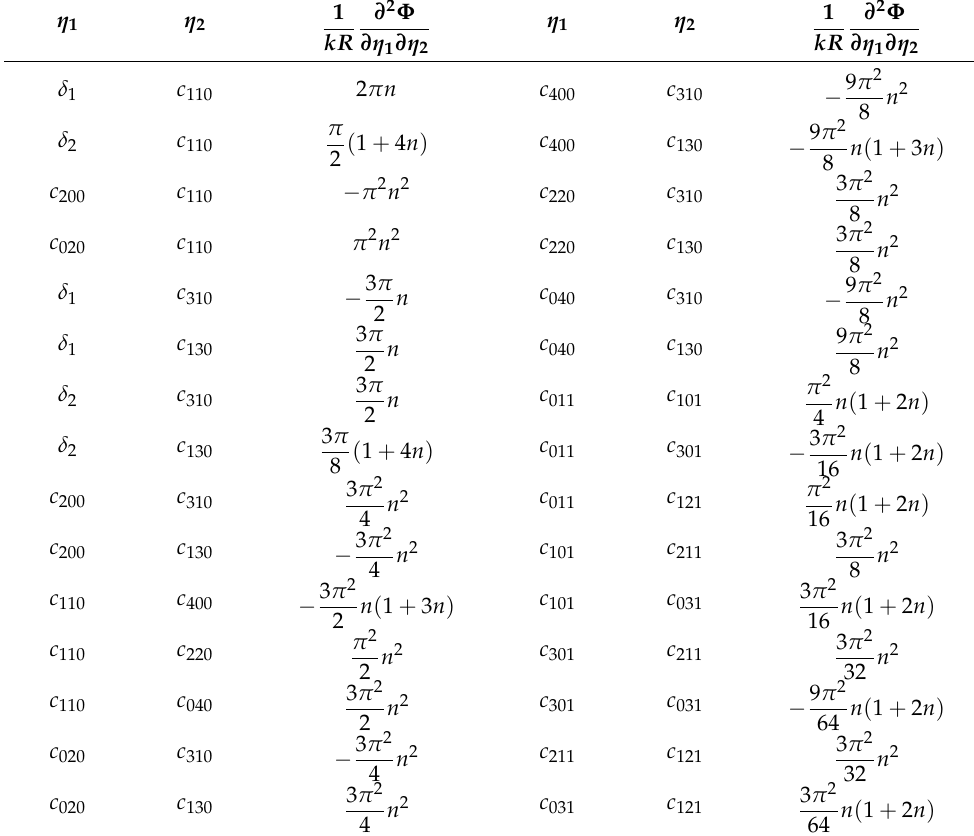
Table 1. Sensitivity of the differential phase Φ to small parameters η i . The phase is normalized by kR for Bragg laser wave number k and nominal orbit radius R . The integer number of orbits is n . Here we show the thirty significant terms observed for a spherically symmetric trap with ζ = 1. The entries below the horizontal line in the second column depend on ζ , as seen in Table